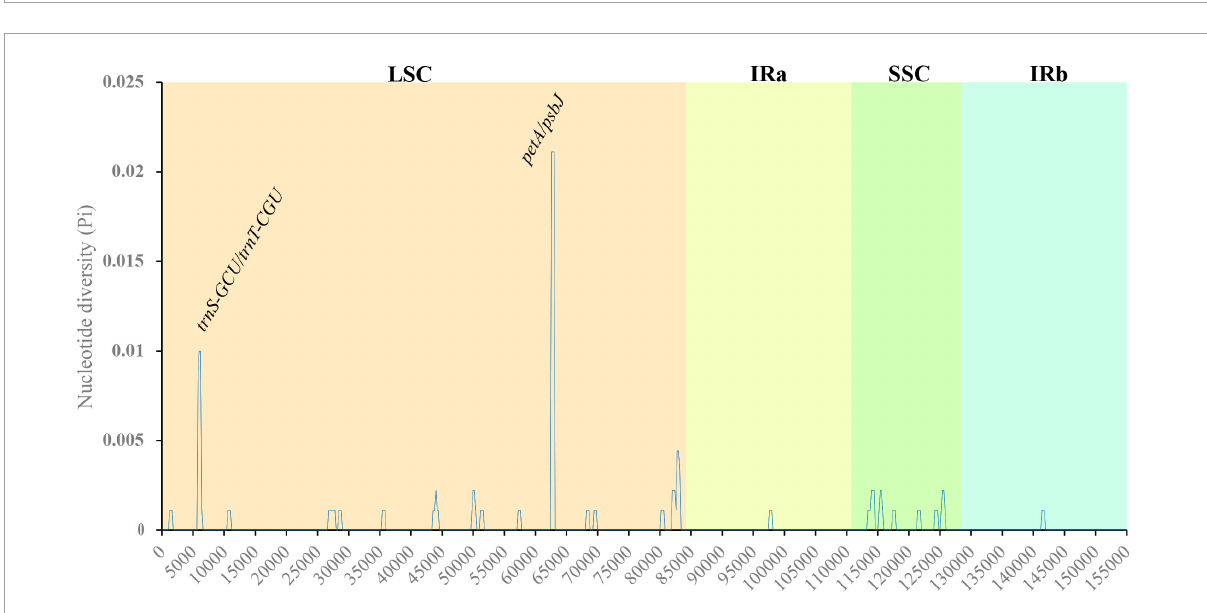
FIGURE5 Variation in nucleotide diversity across the cp genomes of the three studied Salix species. X -axis: position of the midpoint of a window; Y -axis: nucleotide diversity of each